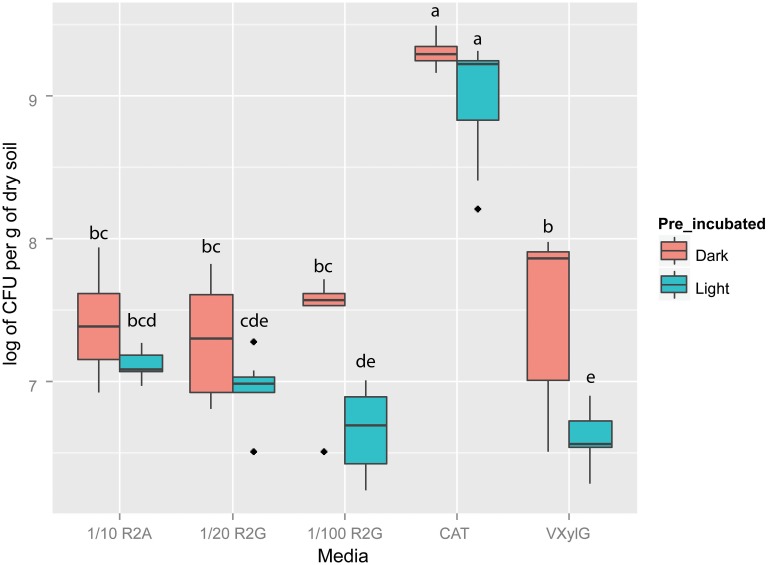
Boxplot of colony forming units on different media (i.e., 1/10 R2A, 1/20 R2G, 1/100 R2G CAT, and VXylG) after 50 days incubation. Vertical bars represent standard deviations of the mean. Top and lower lines of boxes represent, respectively, 75th and 25th percentiles. Horizontal bars represent the medians. Points outside the boxes represent outliers. Light/Dark indicate plates counted from samples incubated, respectively, in the light and in the dark. Boxes with same letters are not statistically different according to t-test (p > 0.05).